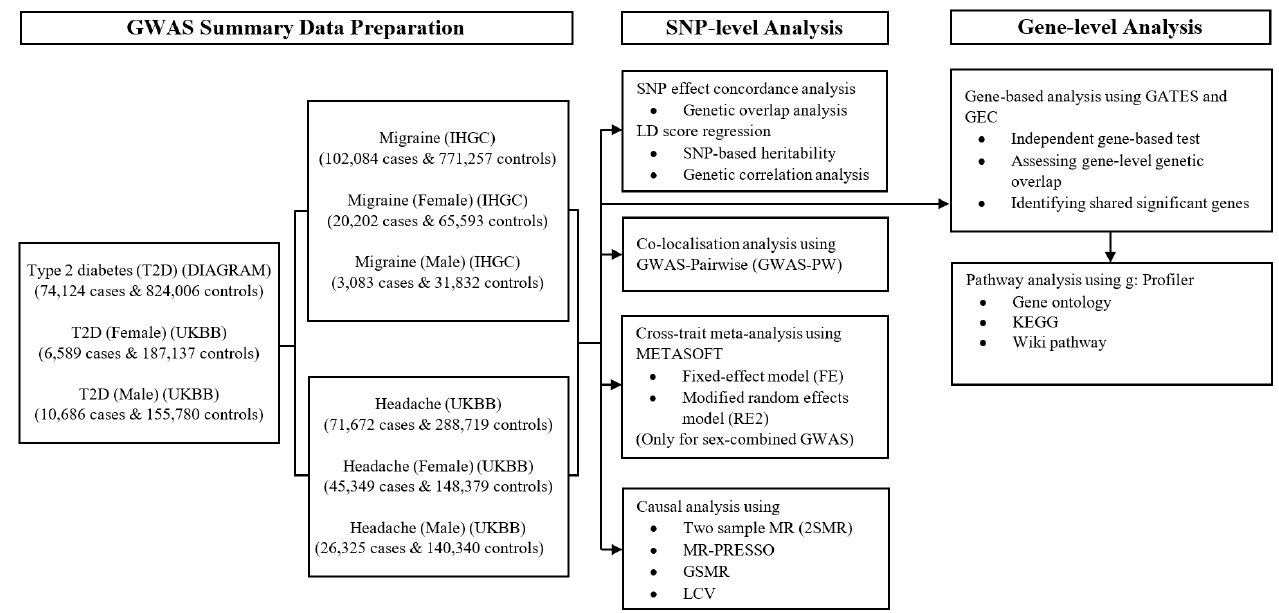
Figure 1. Overall study design and outline of the analysis. IHGC, International headache genetic consortium; DIAGRAM, Diabetes genetics replication and meta-analysis consortium; UKBB, UK Biobank (Neale Lab); PPA, Posterior probabilities of association; LD, Linkage disequilibrium; GATES, Gene-Based Association Test Using Extended Simes Procedure; GEC, Genetic type 1 error calculator; GWAS, Genome-wide association study; KEGG, Kyoto Encyclopedia of Genes and Genomes; LCV, Latent causal variable; MR, Mendelian randomisation; MR-PRESSO, Mendelian randomisation pleiotropy residual sum and outlier; GSMR, Generalised summary data-based Mendelian Randomisation; SNP, Single-nucleotide polymorphism.